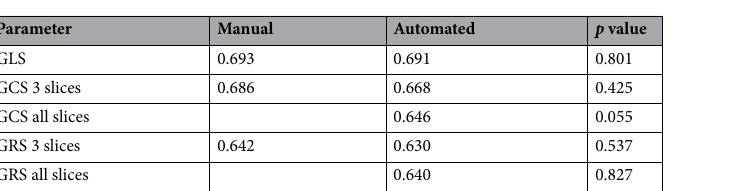
Figure 5. Kaplan–Meier curves assessing survival for manual and automated GLS and GCS. All values dichotomized by their respective medians, time to event represents time to MACE. GCS, global circumferential strain; GLS, global longitudinal strain; MACE, major adverse cardiac events.